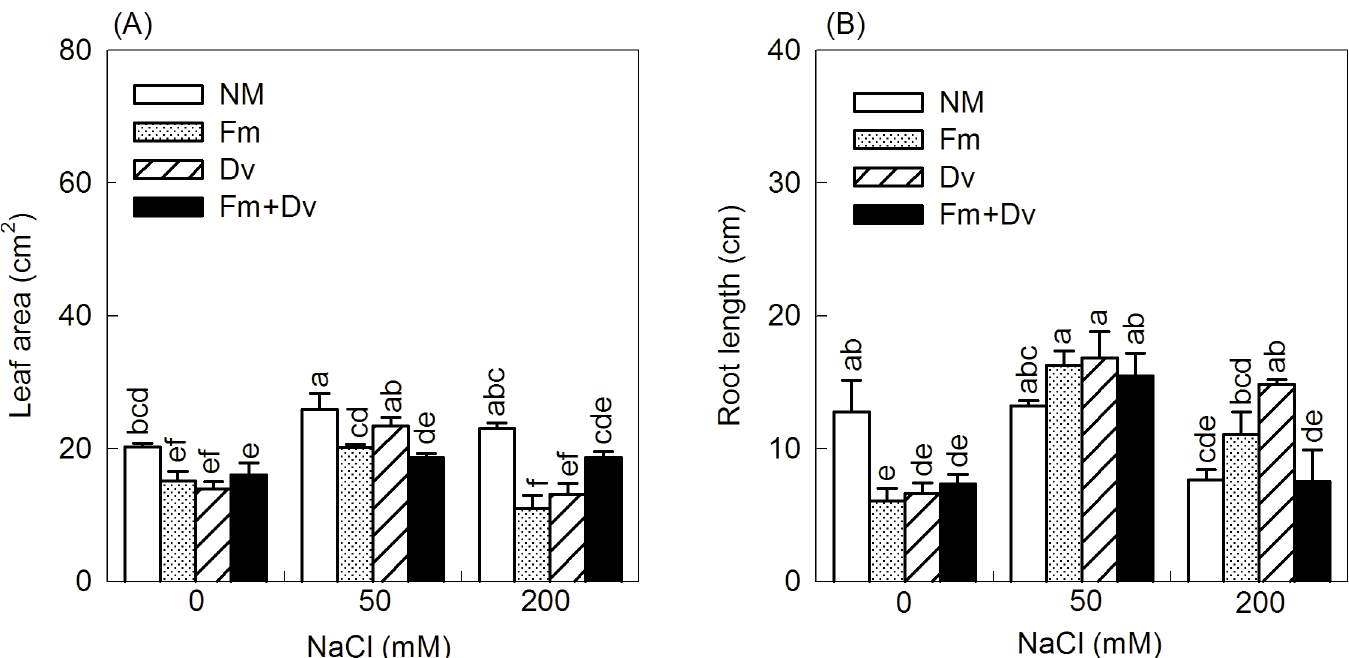
Fig 1. Effects of arbuscular mycorrhizal fungi on leaf area (A) and root length (B) of Chrysanthemum morifolium plants under 0, 50 and 200 mM NaCl. NM, Fm, Dv and Fm+Dv represent inoculation with no mycorrhizal fungi, Funneliformis mosseae , Diversispora versiformis and the combined inoculums, respectively. Values are presented as the mean ± SE. Values followed by the same letter do not differ significantly at P < 0.05 by the LSD multiple range test.